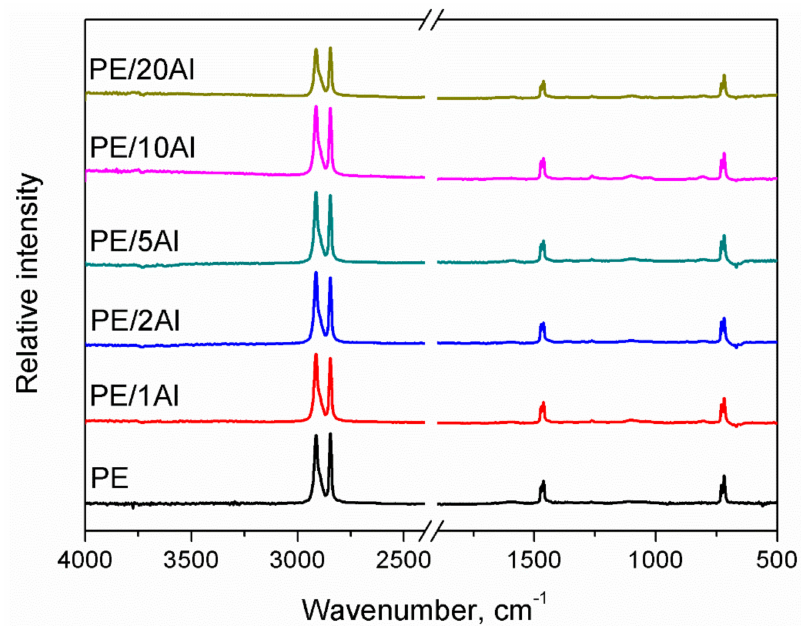
Figure 2. Infrared spectra of polyethylene (PE) and polyethylene / aluminum (PE / Al) composites.